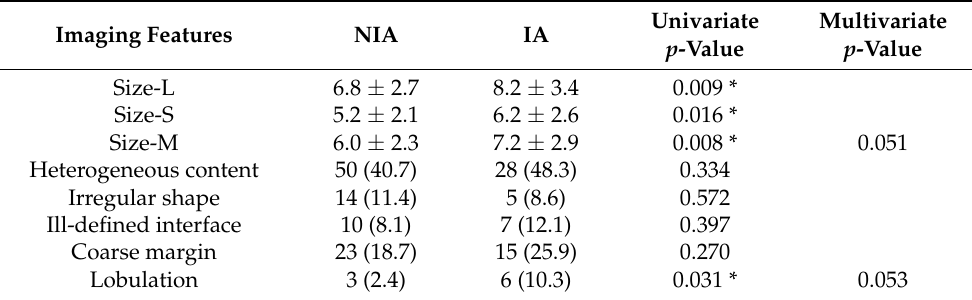
Table 3. Univariate and multivariate analysis between the non-invasive adenocarcinoma (NIA) group and invasive adenocarcinoma (IA)